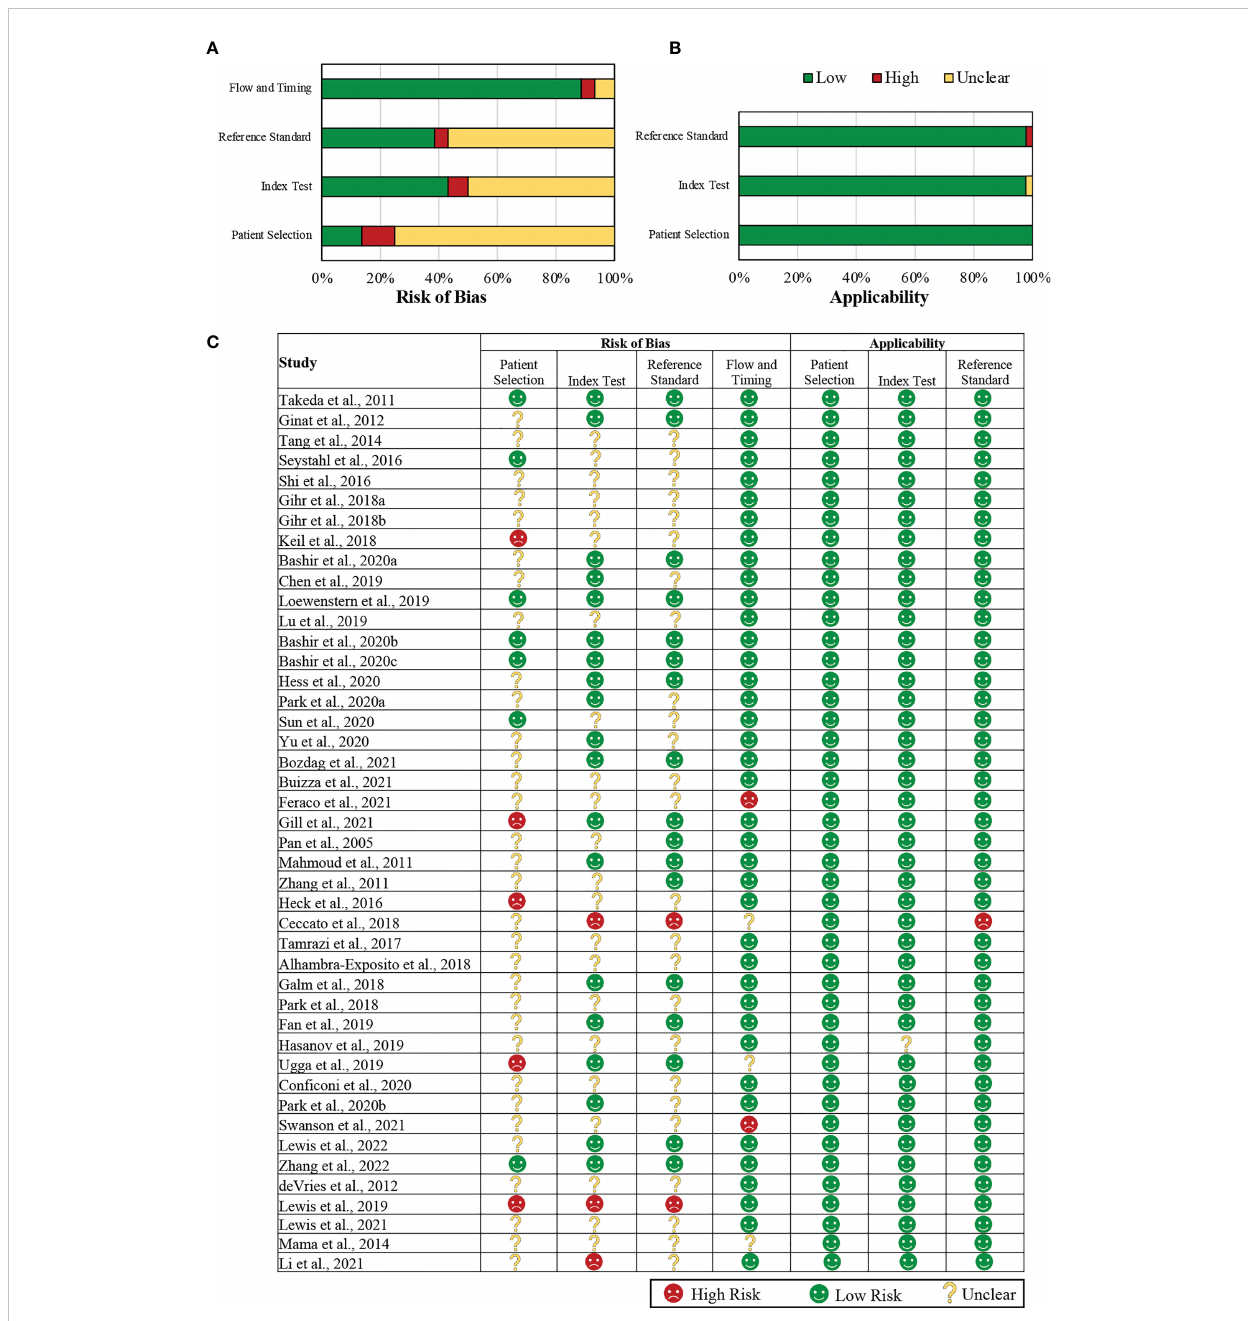
FIGURE 2 Summary of the QUADAS-2 assessments of the included studies. (A) Graphical representation of included studies (in percentages) in each key domain in terms of the risk of bias. (B) A graphical representation of the included studies (in percentages) in each key domain in terms of the concerns regarding their applicability. (C) A tabular representation of the assessments assigned for each included study. QUADAS-2: Quality Assessment of Diagnostic Accuracy